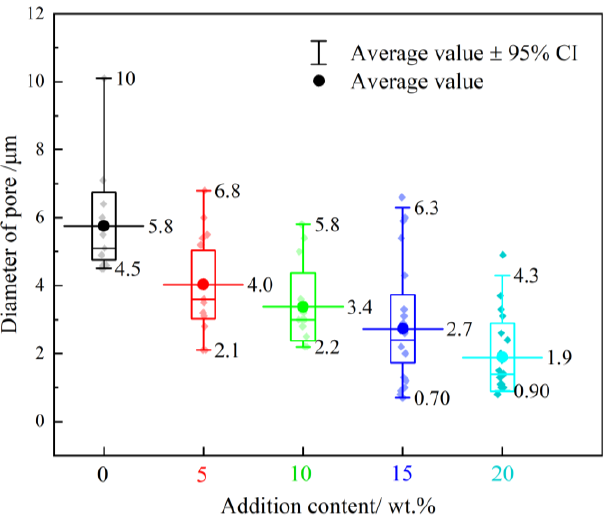
Figure 11. Box plot of hole diameter statistics.